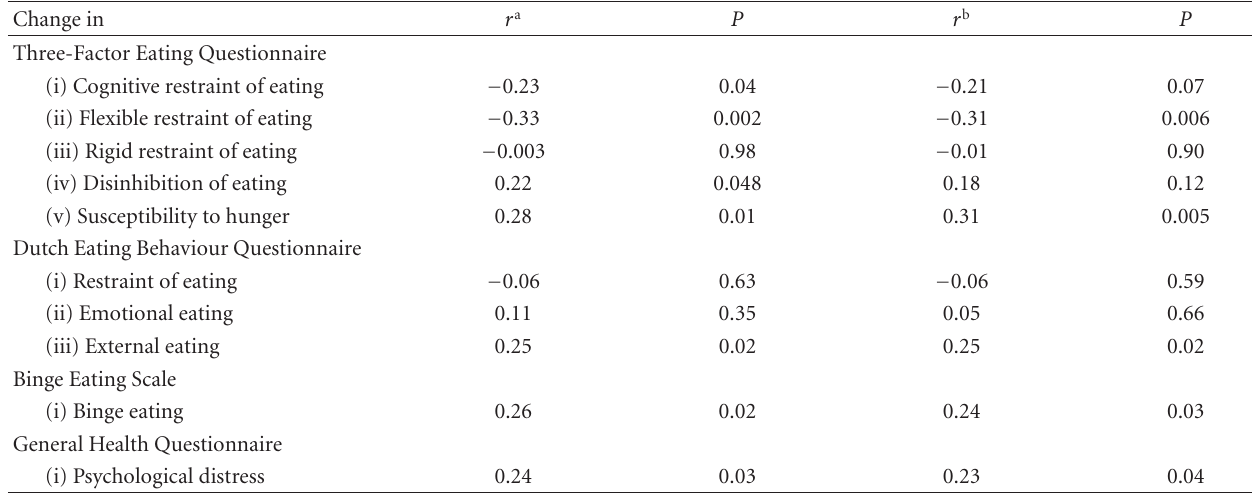
Table 8: Spearman and partial correlation coe ffi cients between the changes in eating behaviour and psychological distress from the beginning of the study to the end of the weight-maintenance period and changes (%) in body weight during the weight-maintenance period ( n =